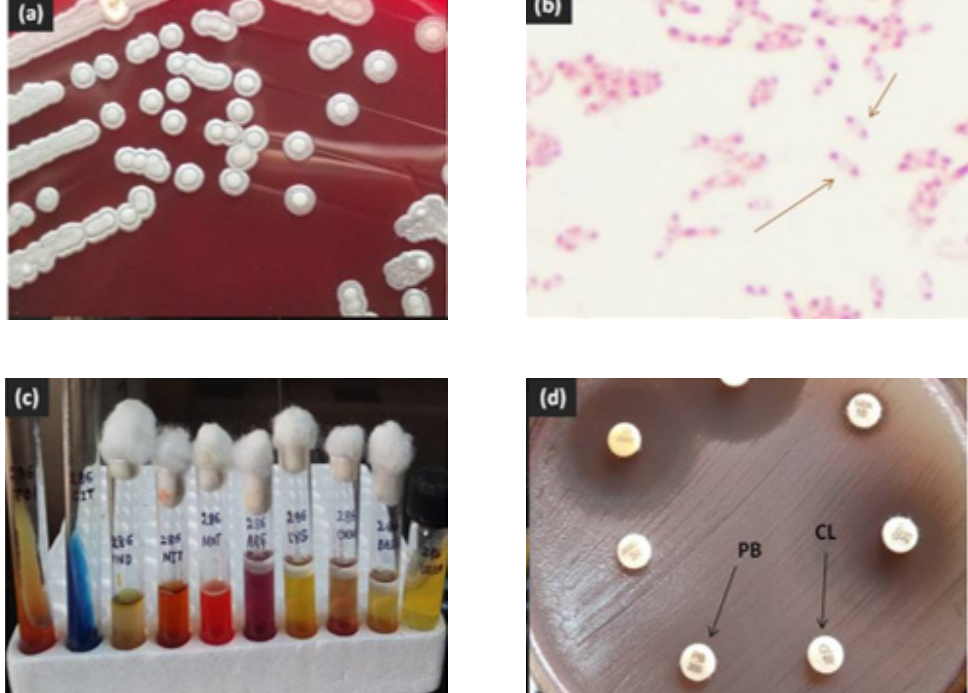
Figure 2. Identification of B. pseudomallei by ( a ) growth on blood agar, ( b ) “safety pin” appearance on Gram stain, ( c ) biochemical reactions, and ( d ) resistance to polymyxin B 300U (PB) and colistin 10µg (CL) disks.